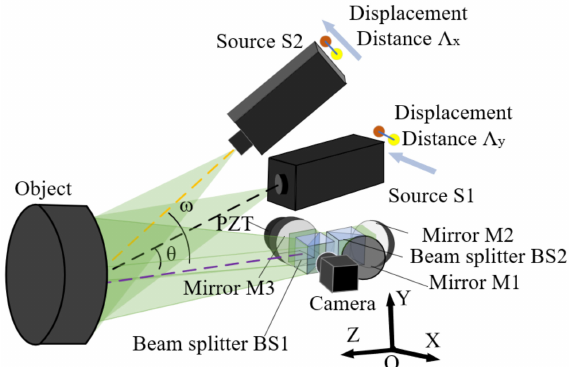
Figure 2. Two-dimensional digital shearography with source displacement. An alternative type of 2D digital shearography with source displacement is shown in Figure 3. Two lasers with wavelengths of 532 nm and 660 nm act as the laser sources. One laser source (named S1’) is in the XOZ plane and the other (named S2’) is in the YOZ plane. Their illumination angles are the same size. The imaging device used here is a color camera. The shearing device is composed of a beam splitter, two mirrors, and a dichroic filter. The dichroic filter, which can transmit green light and reflect red light, is placed between the beam splitter BS1 (cid:48) and the mirror M2 (cid:48) . The filter is tilted in the X direction to introduce a sheared image formed by the red light. The other sheared image is formed by the green light which is reflected by the mirrors M1 (cid:48) and M2 (cid:48) . The mirror M2 (cid:48) has a small inclination angle in the YOZ plane. The two images are captured simultaneously by the color camera and recorded in the corresponding color channels. Consequently, the 2D slopes are obtained simultaneously.